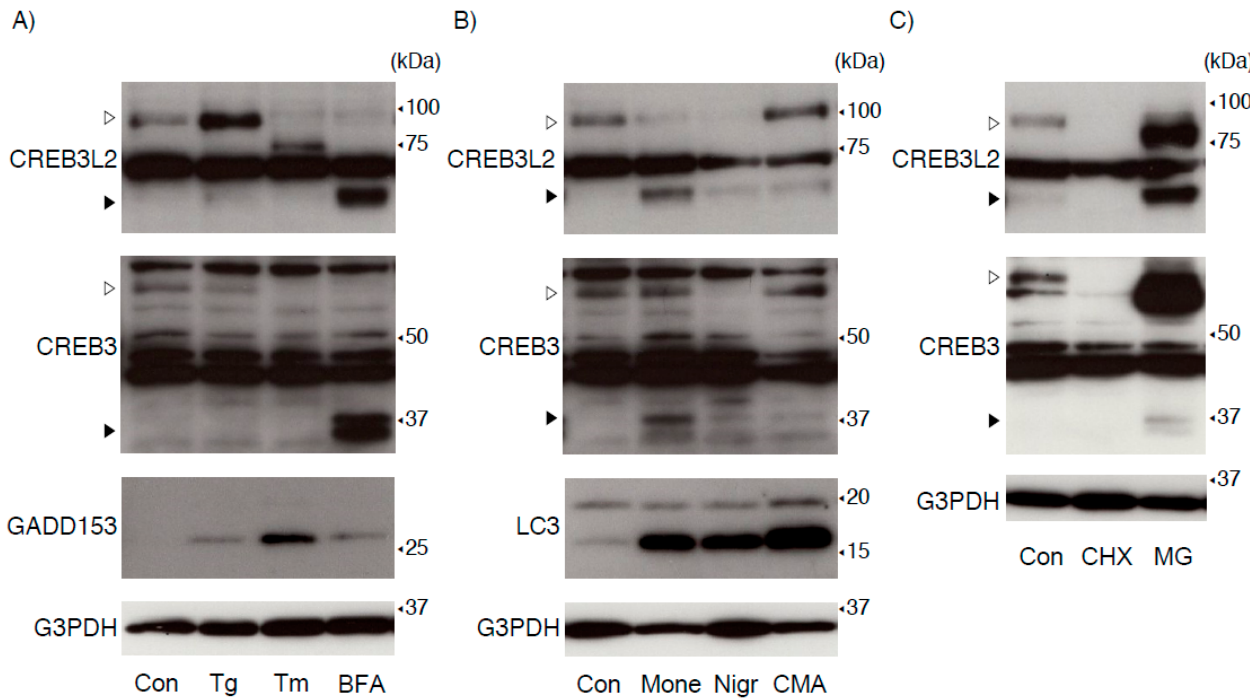
Figure 1. Expression of the CREB3 and CREB3L2 proteins in HEK293 cells. ( A – C ) HEK293 cells were treated with thapsigargin (Tg, 0.01 µ M), tunicamycin (Tm, 2 µ g/mL), brefeldin A (BFA, 0.5 µ g/mL), monensin (Mone, 1 µ M), nigericin (Nigr, 0.2 µ M), concanamycin A (CMA, 50 nM), cycloheximide (CHX, 20 µ g/mL), MG132 (MG, 10 µ M), or vehicle (Control (Con)) for 8 h. The expression of the indicated protein was detected as described in the Materials and Methods. Open and filled arrowheads indicate full-length mature and cleaved CREB3 and CREB3L2 proteins, respectively. Representative results of three independent cultures are shown.